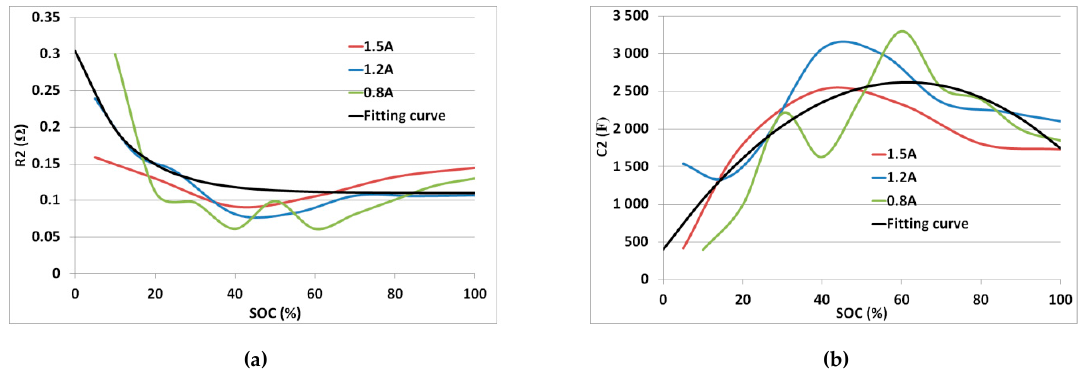
Figure 7. Values of concentration parameters versus SOC for different discharge currents ( a ) resistance